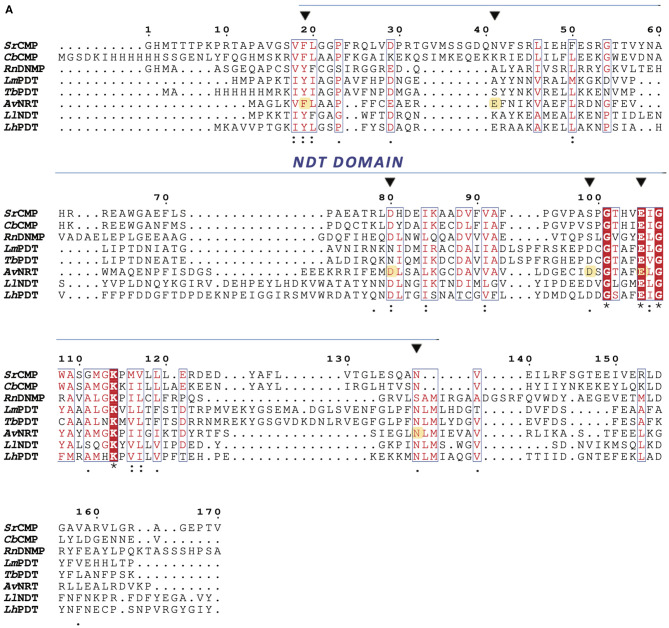
Multiple sequence alignment of type I NDTs (PDTs) from Lactobacillus helveticus (LhPDT), Trypanosoma brucei (TbPDT), and Leishmania mexicana (LmPDT), a type II NDT from Lactobacillus leichmannii (LlNDT), and NMP glycosidases from Streptomyces rimofaciens (SrCMP, MilB), Clostridium botulinum (CbCMP, BcmB), Rattus norvegicus (RnDNMP, Rcl). Amino acids for each polypeptide sequence were independently numbered. Active site residues are indicated by an inverted black triangle (▼) and highlighted in yellow in the AvNRT amino acid sequence. An asterisk (*) indicates single, fully conserved residues; a colon (:) indicates conservation of strong groups; and a period (.) indicates conservation of weak groups.